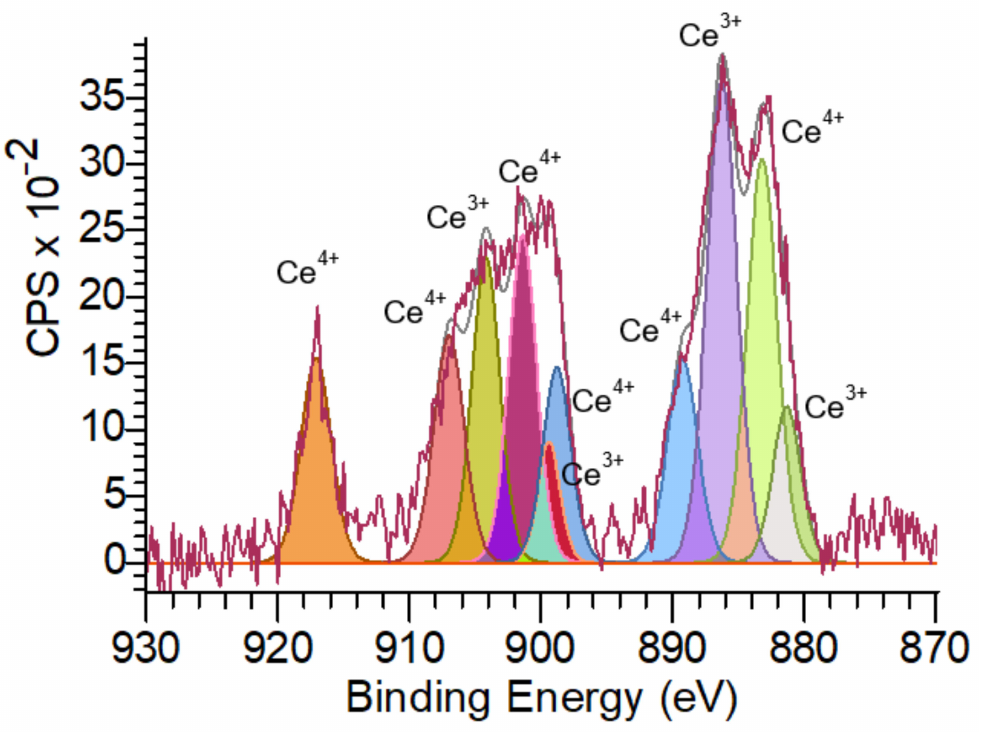
Figure 7. X-ray photoelectron Ce 3 d spectrum of CeO 2